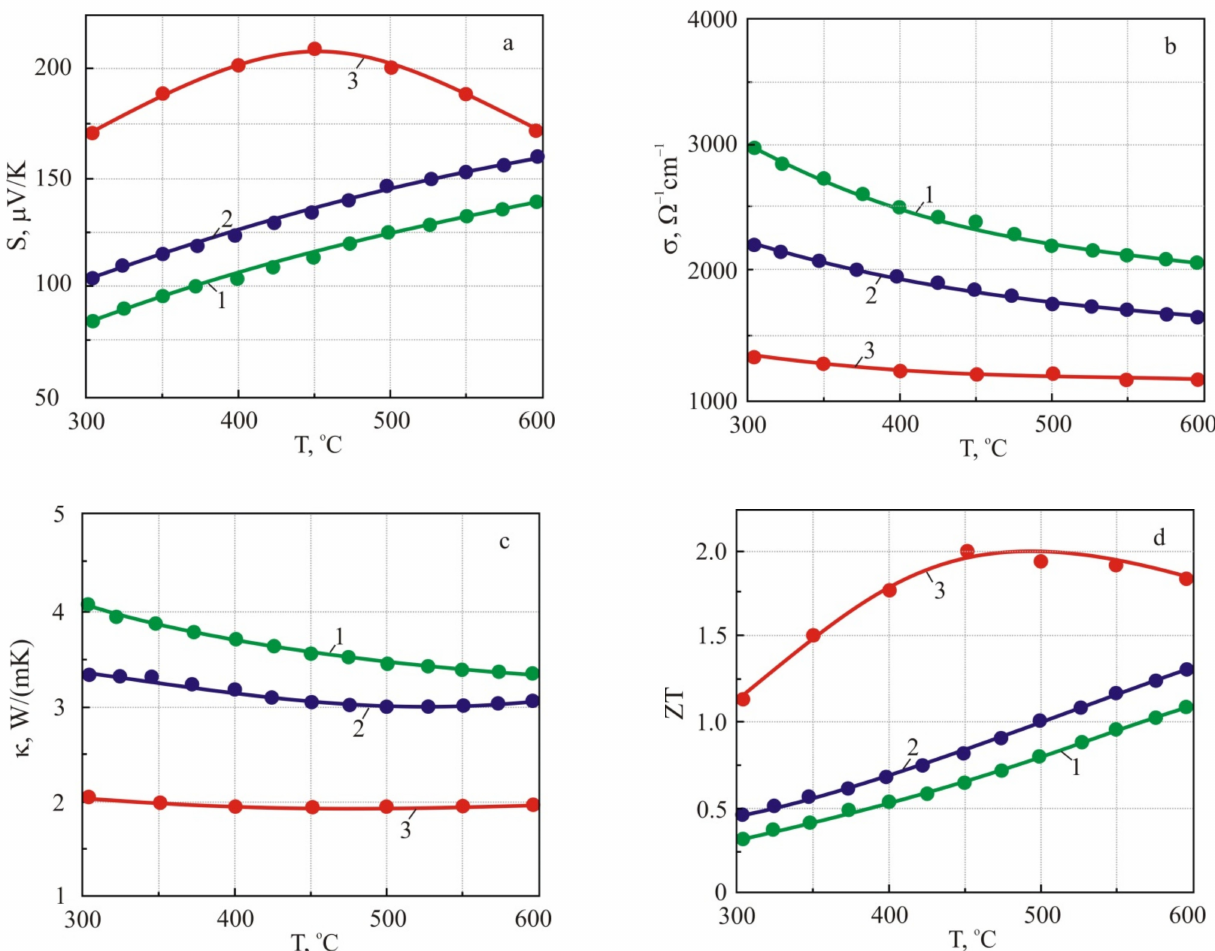
Figure 11. The temperature dependence of Seebeck coefficient ( a ), electrical conductivity ( b ), thermal conductivity ( c ), and the dimensionless figure of merit ZT ( d ) over 300–600 ◦ C temperature range for p -Type Ge 1 − x − y Bi x Pb y Te prepared by SPS. 1—GeTe. 2—Ge 0.94 Pb 0.06 Te. 3—Ge 0.96 Bi 0.04